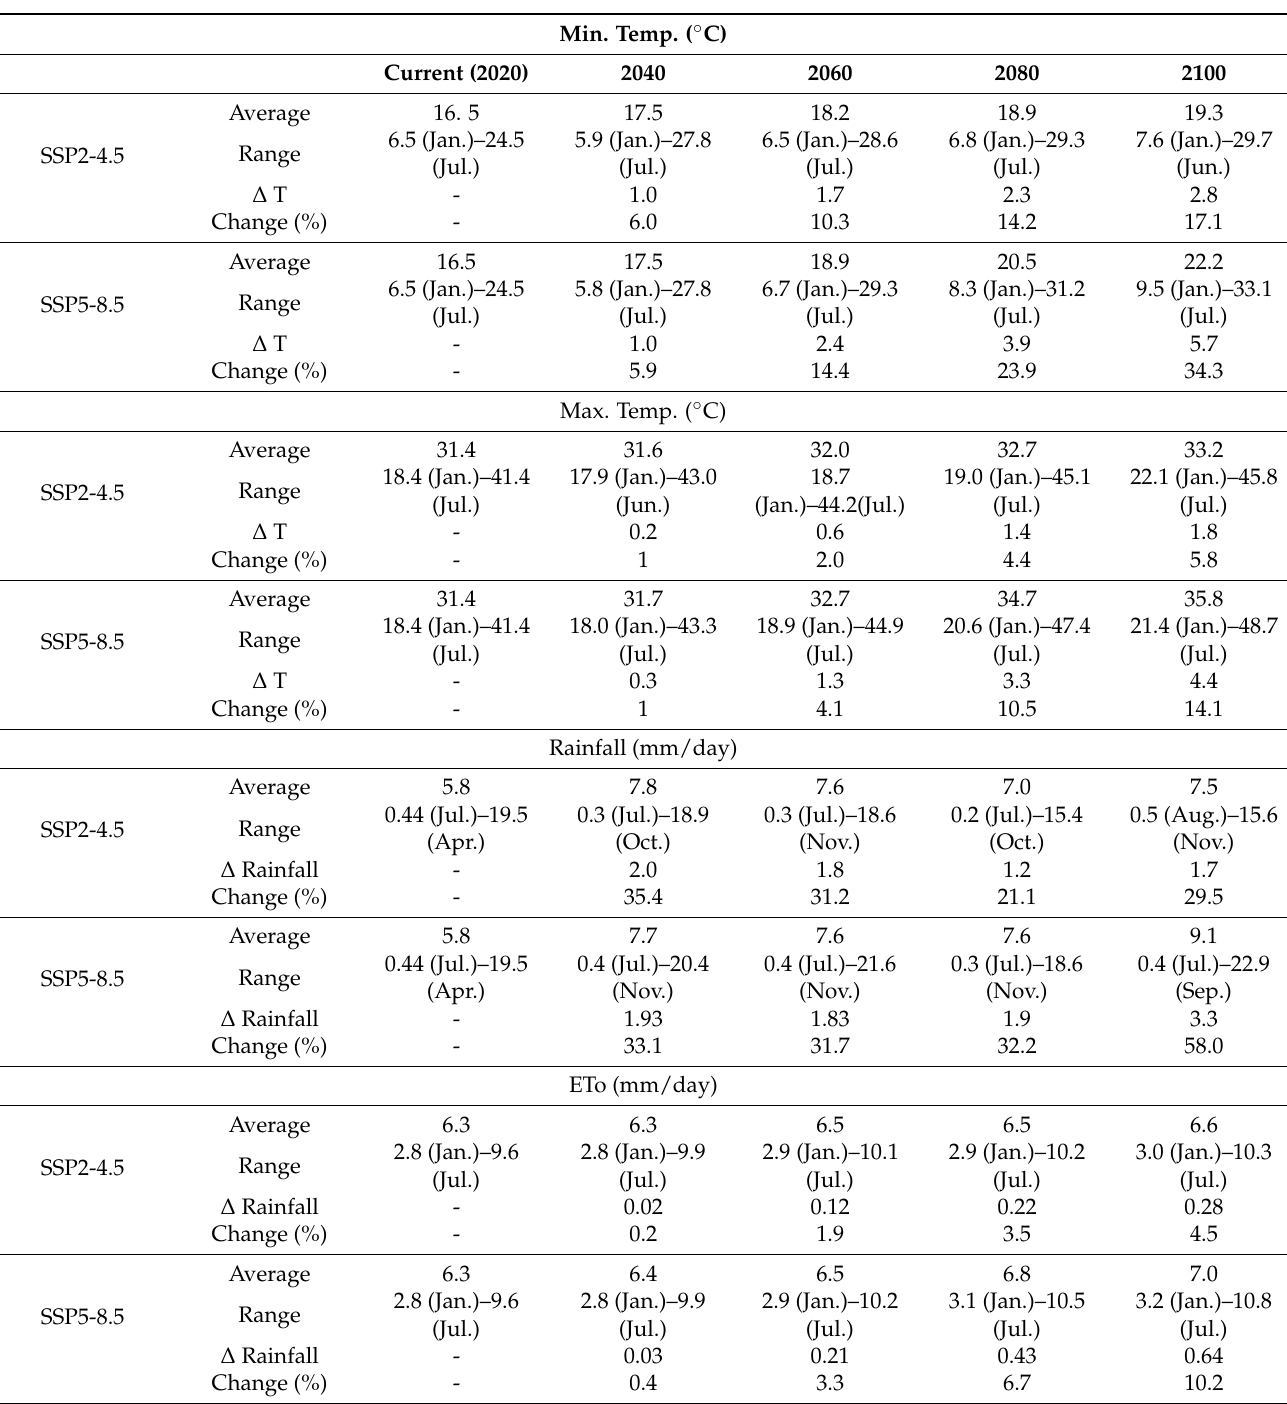
Table 6. Minimum and maximum temperatures ( ◦ C) and rainfall (mm) (average, range, difference, and change) for the 2040s, 2060s, 2080s, and 2100s under SSP2-4.5 and SSP5-8.5 using data from the four CMIP6 climate models and current conditions (2020) for the Al Quassim region. Min. Temp. ( ◦